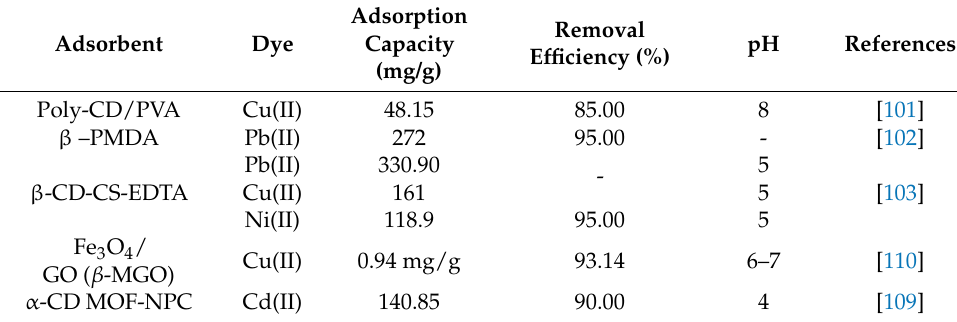
Table 2. Adsorption capacities of various CD-based adsorbents for